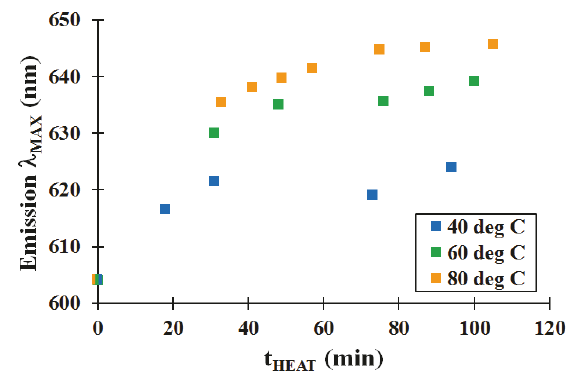
Figure 5: Effect of heating temperature on mercaptosuccinic acid- modified